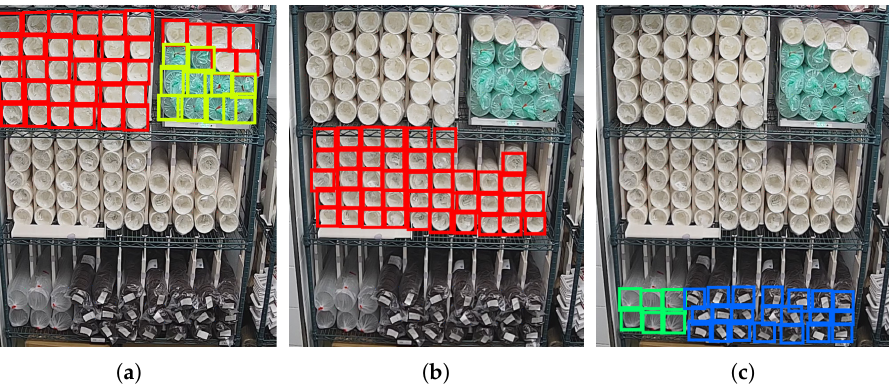
Figure 14. Detection results with different detection area. ( a ) The first layer. ( b ) The second layer. ( c ) The last layer.